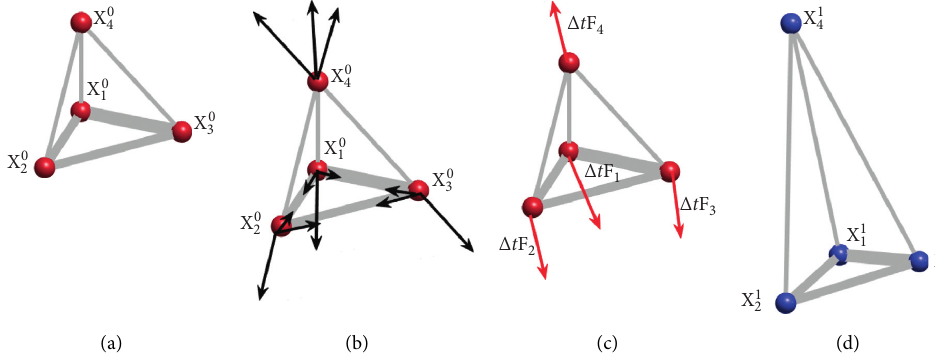
Figure 4: Schematic illustration of the proposed algorithm. (a) Initial state of four nodes. (b) Direction of forces acting on each node. (c) Net force direction of each point. (d) Position of four nodes after 1 iteration using the proposed method. Here, the normalized weight matrix W in equation (10) is